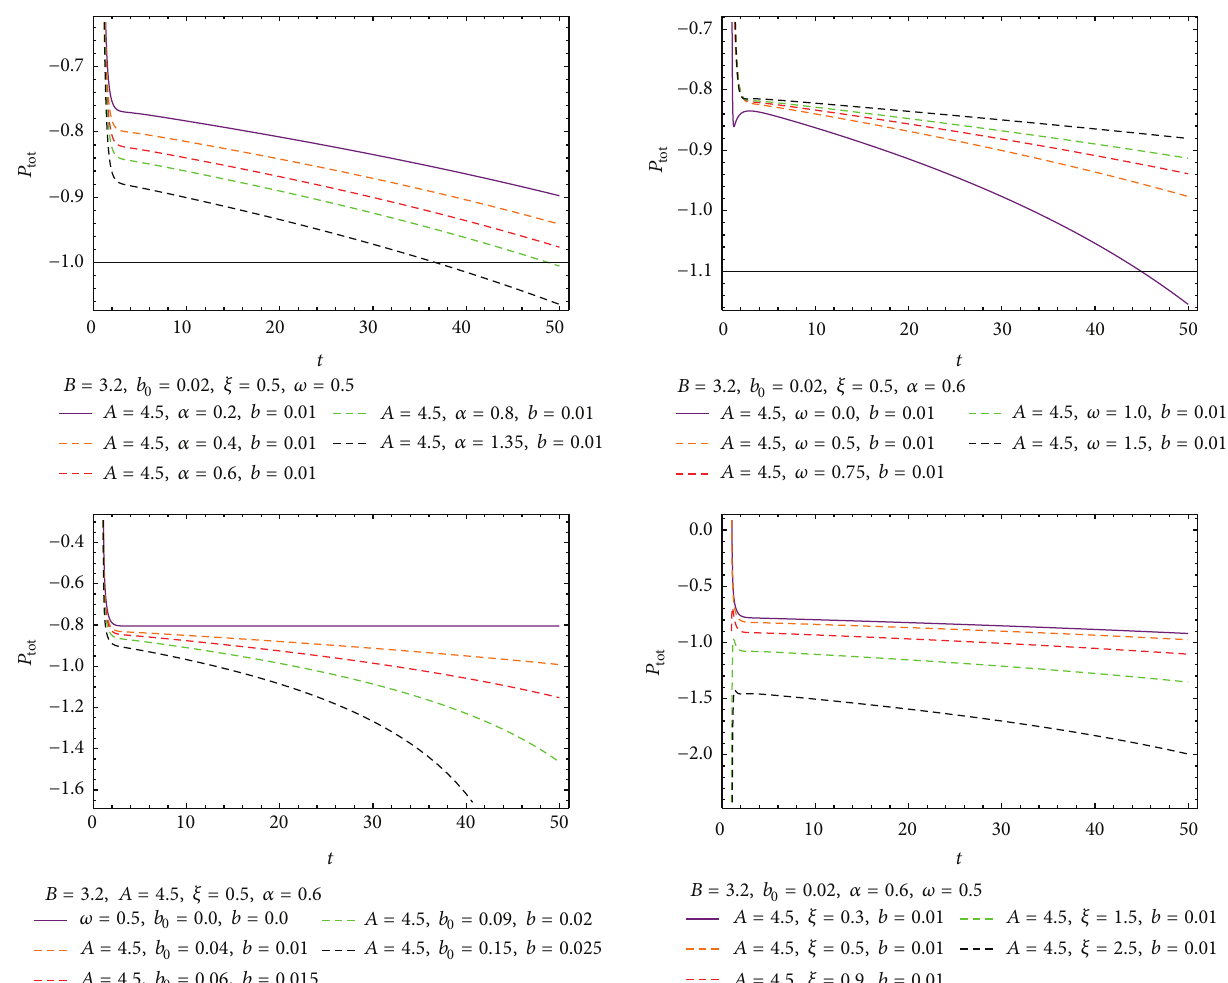
Figure 9: Behavior of 𝑃 against 𝑡 for interacting barotropic fluid and viscous Chaplygin tot